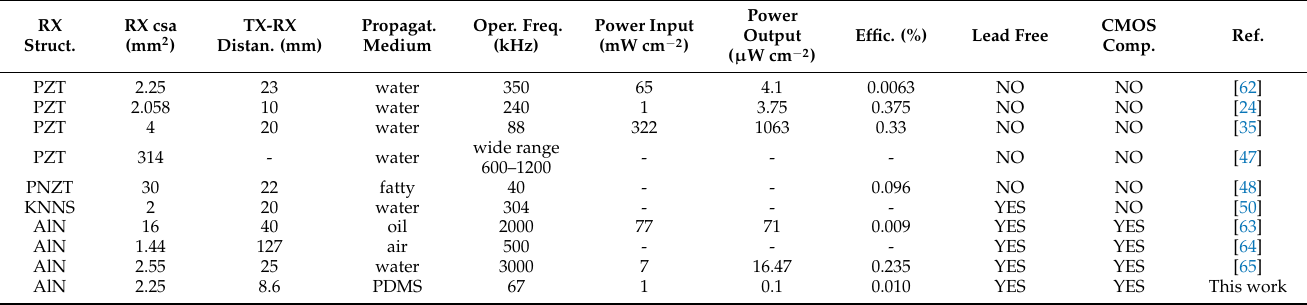
Table 7. Comparison between ultrasound pMUT